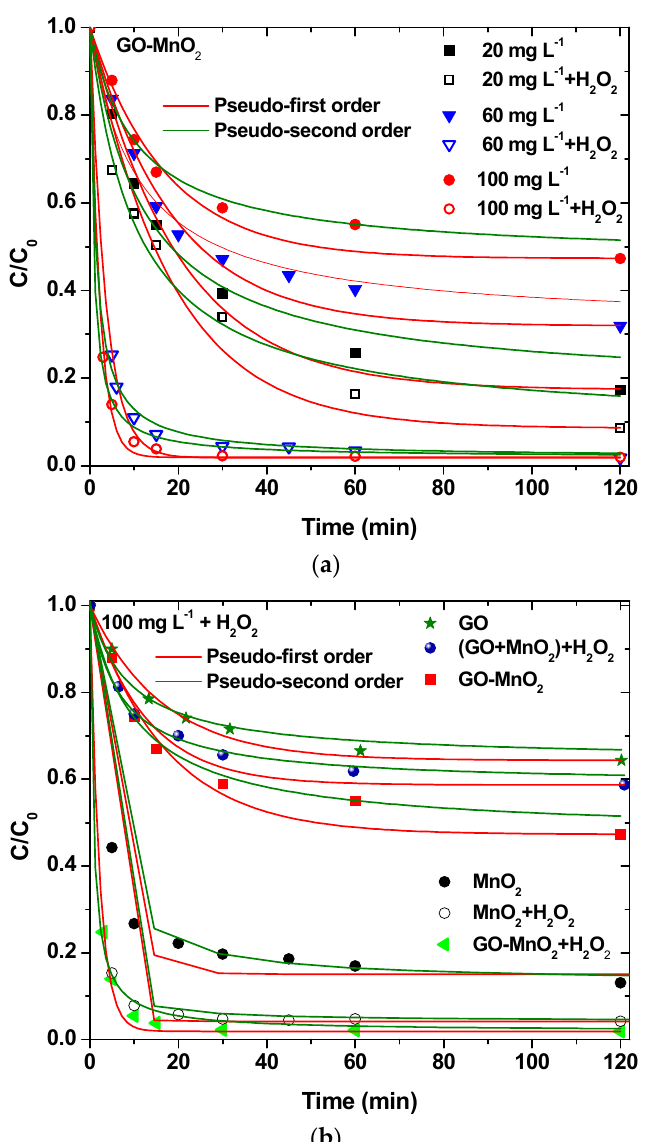
Figure 6. ( a ) Effect of H 2 O 2 at different initial concentrations on RB5 removal by GO ‐ MnO 2 ; ( b ) effect of the comparison between the nanocomposite catalyst and the mixture of the raw materials performance on RB5